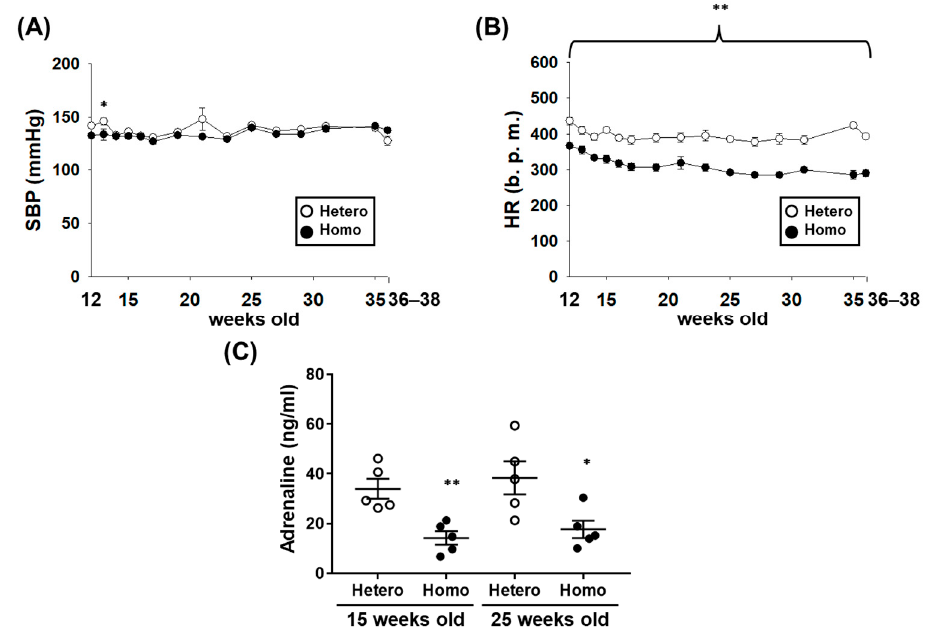
Figure 2. The cardiovascular dynamics of ZFDM rats. ( A , B ) The systolic blood pressure (SBP) ( A ) and heart rate (HR) ( B ) of ZFDM rats at 12 ( n = 10), 13–16 (Hetero: n = 9, Homo: n = 10), 17–35 (Hetero: n = 8, Homo: n = 10), and 36–38 (Hetero: n = 8, Homo: n = 9) weeks old were measured by a tail-cuff method under conscious condition. ( C ) The adrenaline concentration in heparin (1 U/mL)-anticoagulated plasma of ZFDM rats at 15 and 25 weeks old ( n = 5) was measured by a commercially available ELISA kit. Results were expressed as means ± SEM. * p < 0.05, ** p < 0.01 vs. Hetero.